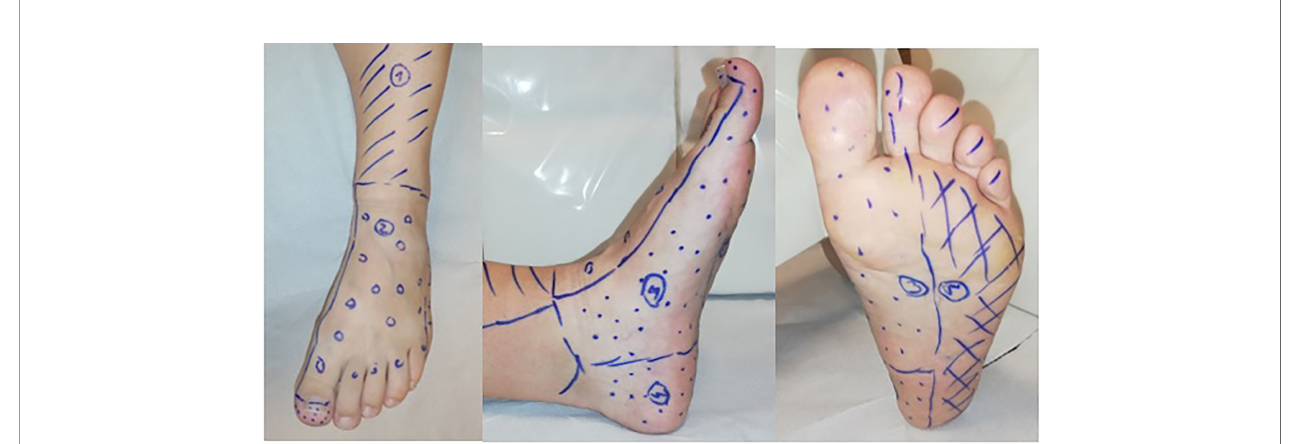
FIGURE 1 | Distribution of angiosomes in the lower limb. 1- Angiosomes supplied by: anterior tibial artery (ATA); 2 - dorsalis pedis artery (DPA); 3 – medial plantar artery; 4 - calcaneal branch of the posterior tibial artery (PTA) (angiosomes 3 and 4 are supplied by the PTA); 5 - lateral plantar artery.